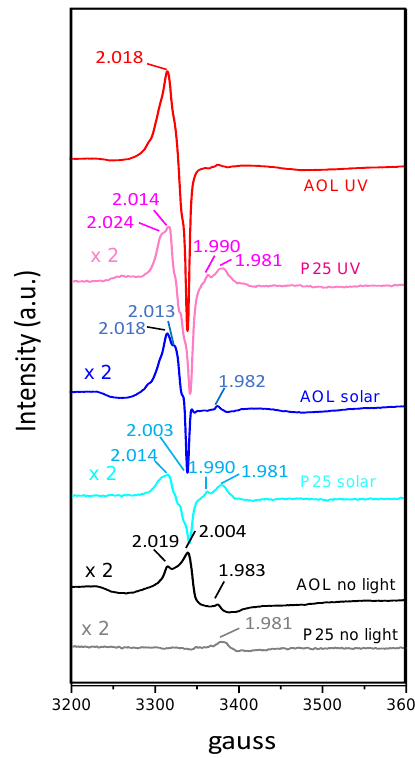
Figure 7. EPR spectra of Evonik P25 and AOL with (UV or solar) and without irradiation.